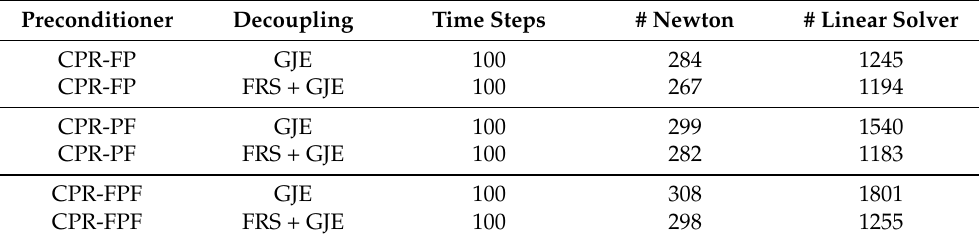
Table 12. Numerical summaries of Example